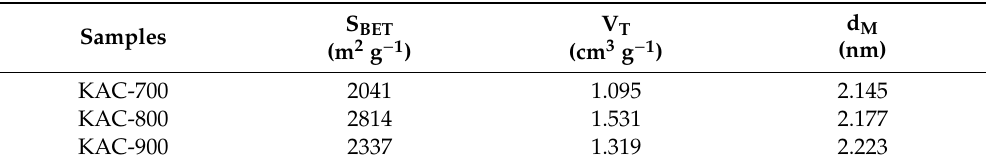
Figure 1. N 2 adsorption-desorption isotherms of samples. Table 1. Textural properties of samples (calculated total surface area S BET , total pore volume V T , and average pore diameter d M ).